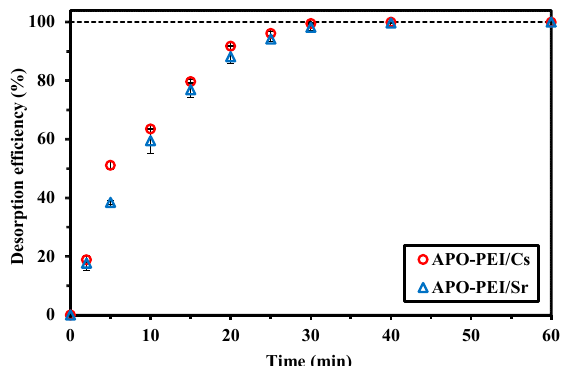
Figure A19. Cs(I) and Sr(II) desorption kinetics for APO-PEI sorbent: case of binary systems (metal- loaded samples collected at equilibrium from the relevant kinetics; SD: 2.67 g L − 1 ; eluent: 0.2 M HNO 3 ; v: 210 rpm; T: 21 ± 1 °C).